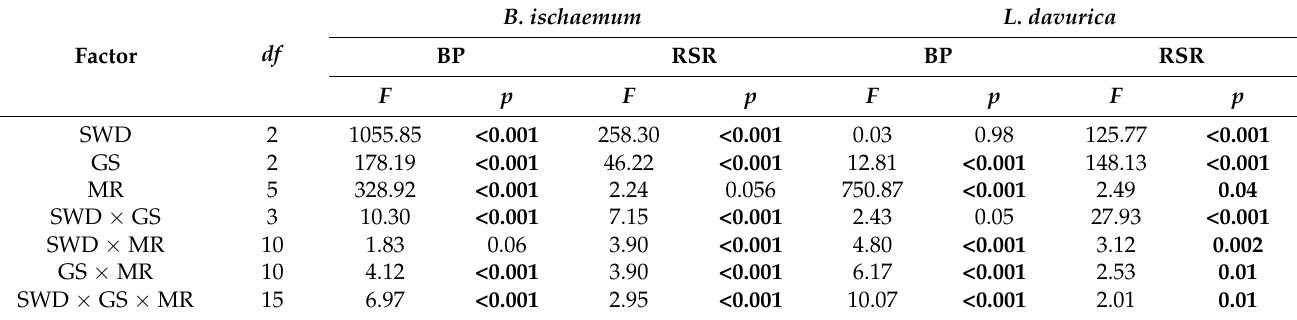
Table 2. Results of three-way ANOVA testing the effects of soil water decreasing (SWD), growth stage (GS), mixture ratio (MR), and their interactions on biomass production (BP) and root/shoot ratio (RSR) of the two species in the